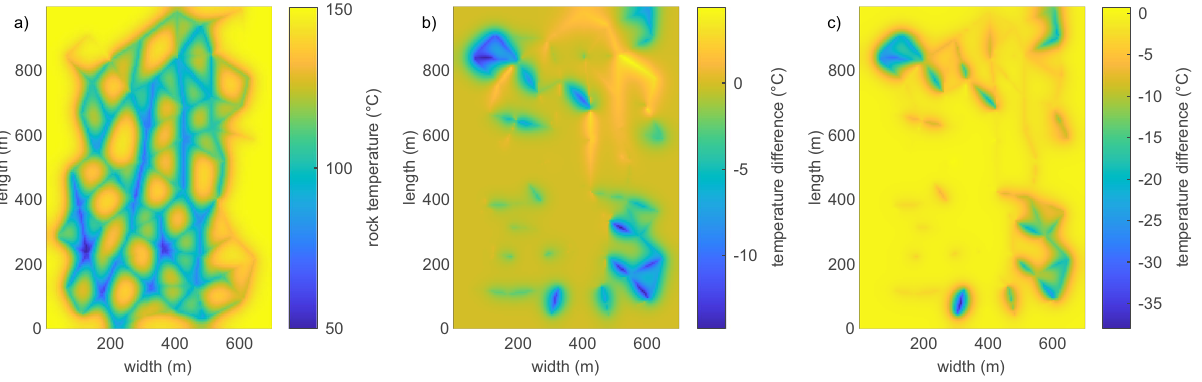
Fig. 7 | Temperature distribution. Rock temperature for the velocity-dependent heat transfer ( a ) and differences to this distribution for h =100W = ð m 2 (cid:3) C Þ ( b ) and h =190W = ð m 2 (cid:3) C Þ ( c ) in the reservoir consisting of 116 fractures after 30 years of